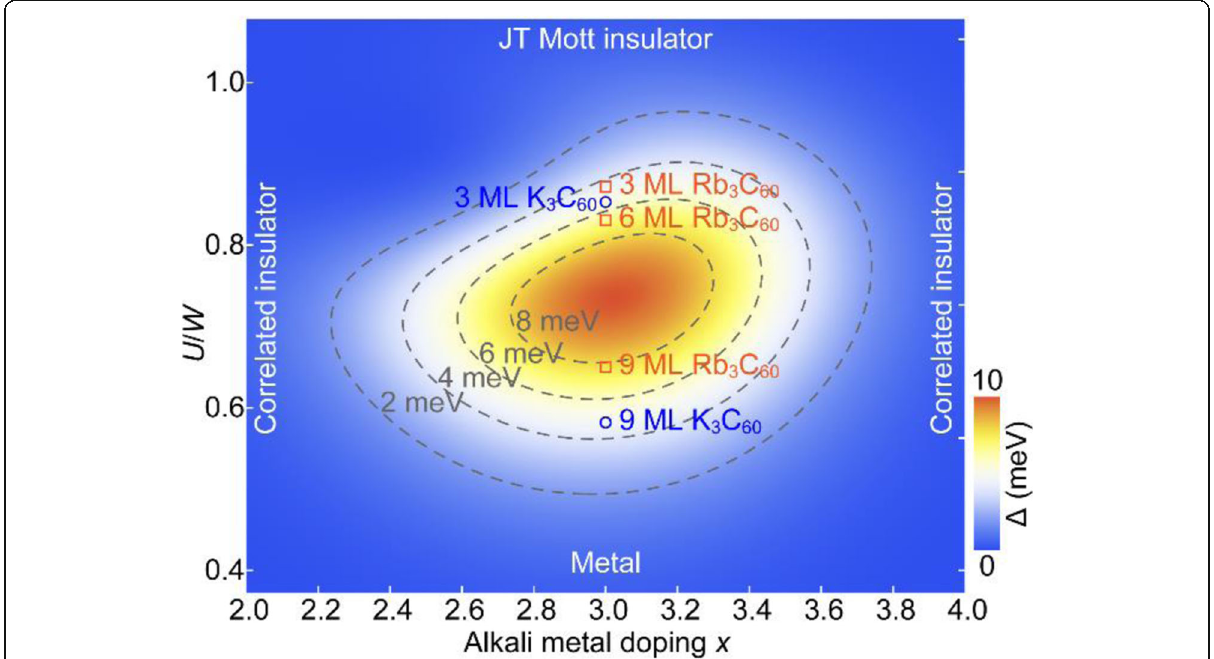
Fig. 19 Unified phase diagram of Δ variation with electronic correlations U and doping. The empty circles and squares mark the experimental Δ measured in K 3 C 60 and Rb 3 C 60 films, respectively. Contour plots of Δ with a separation of 2 meV are shown in gray dashes. Taken from ref.